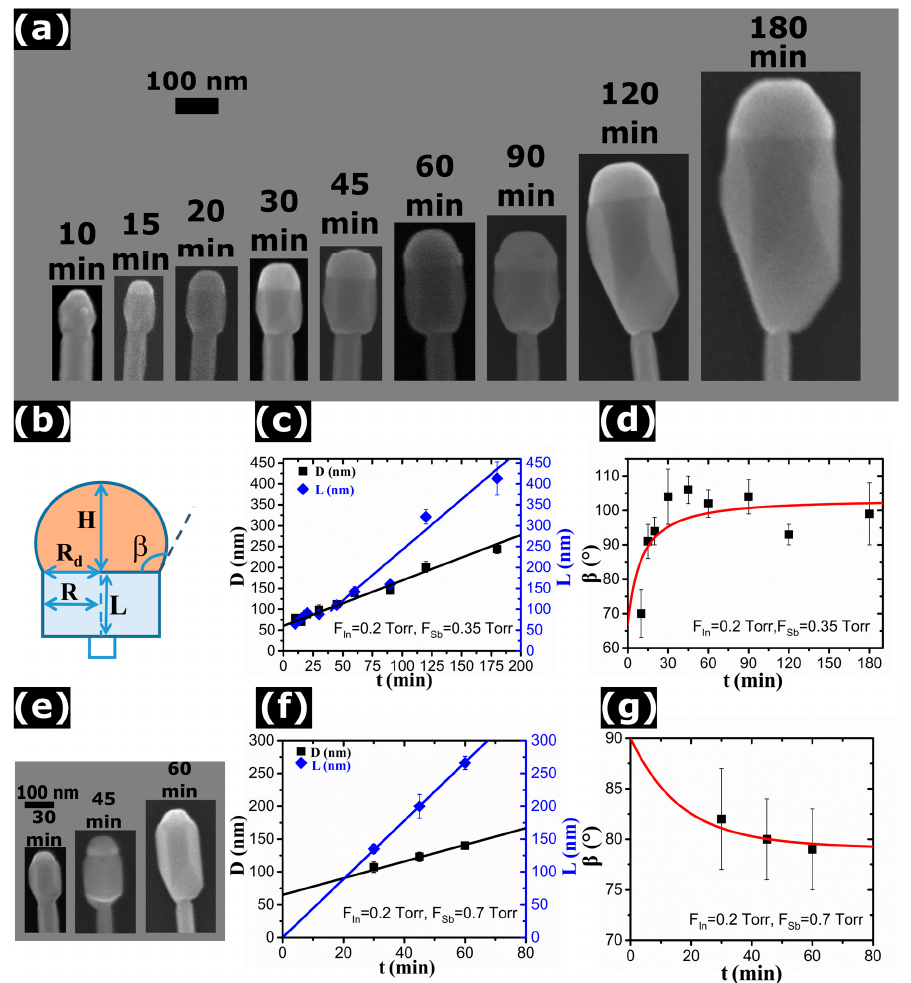
Figure 1. ( a ) Series of SEM images of InAs / InSb axial heterostructured NWs with In droplets on top, obtained with the line pressures F In = 0.2 Torr and F Sb = 0.35 Torr for different InSb growth times as indicated in each panel. The In droplet nucleates smaller than the NW facet, but then extends its base to cover the whole NW already after 15 min of InSb growth. ( b ) Schematic view of the measured geometrical parameters. ( c ) Time evolution of the diameter and length of InSb segments (symbols) and ( d ) time evolution of the contact angle of In droplets on top of InSb segments (symbols) of the sample series shown in ( a ). ( e ) Series of SEM images of InAs / InSb axial heterostructured NWs with In droplets on top, obtained under F In = 0.2 Torr and F Sb = 0.7 Torr for 30, 45, and 60 min of InSb growth time. The droplet diameter appears systematically smaller than the NW diameter. ( f ) Time evolution of the diameter and length of InSb segments (symbols) and ( g ) time evolution of the contact angle of In droplets on top of InSb segments (symbols) of the sample series shown in ( e ). The lines in ( c , d , f , g ) are theoretical fits discussed in the modeling